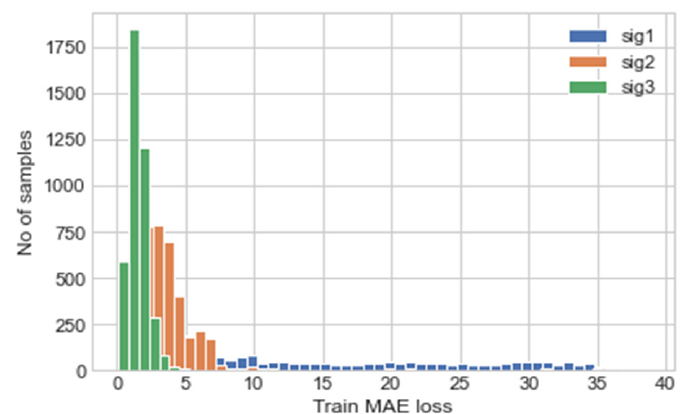
Figure 13. Histogram depicting MAE of each prediction for each input/output channel.